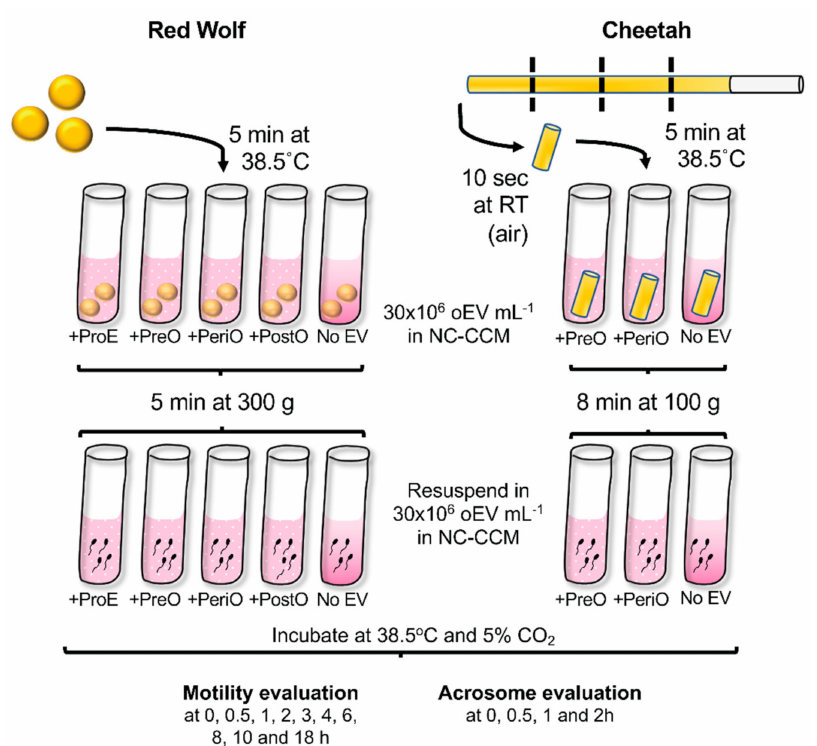
Figure 5. Experimental design of red wolf and cheetah sperm thawing with / without oEVs. NC-CCM = non-capacitating canine capacitation medium; ProE = proestrus; PreO = pre-ovulatory; PeriO = peri-ovulatory; PostO =